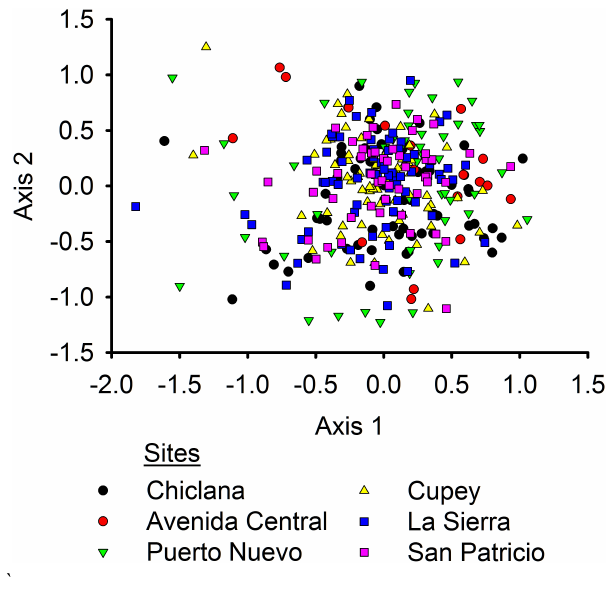
Fig. 5 . NMS Ordination evaluating variation among Río Piedras watershed sites in species composition. The variation in plant composition is equally represented across sites and there are no side difference in overall species